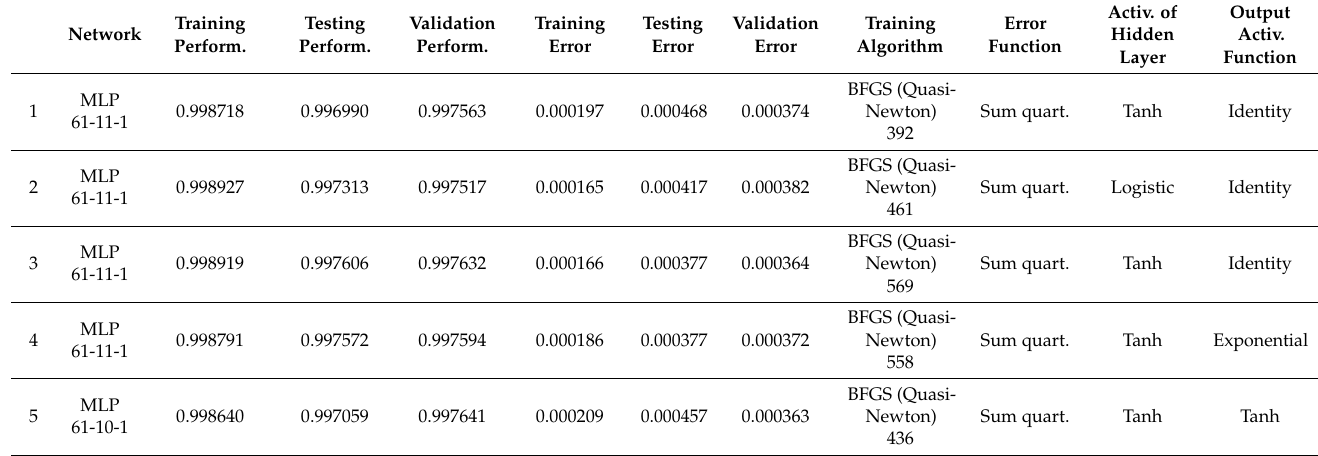
Table 5. Retained neural